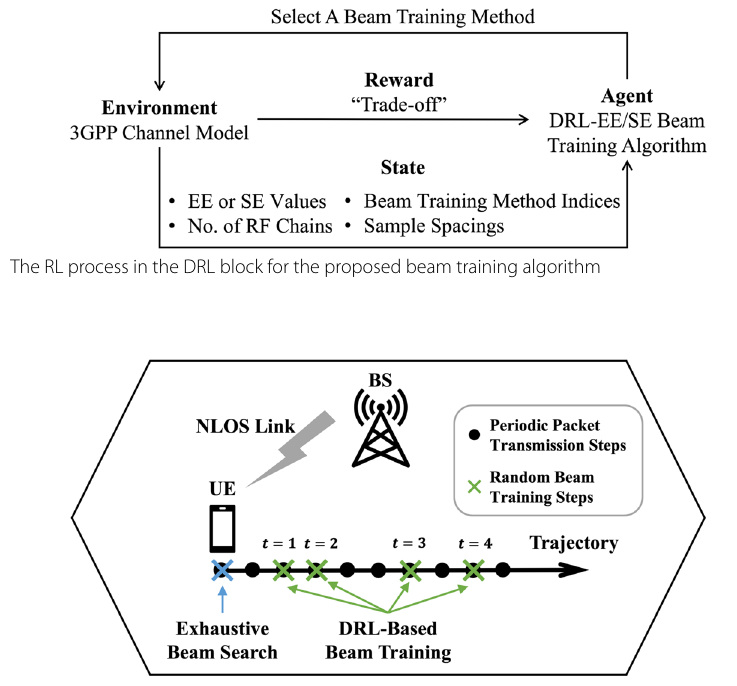
Fig. 5 An illustration of the simulation